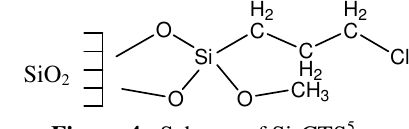
Figure 4. Scheme of Si-CTS 5 .